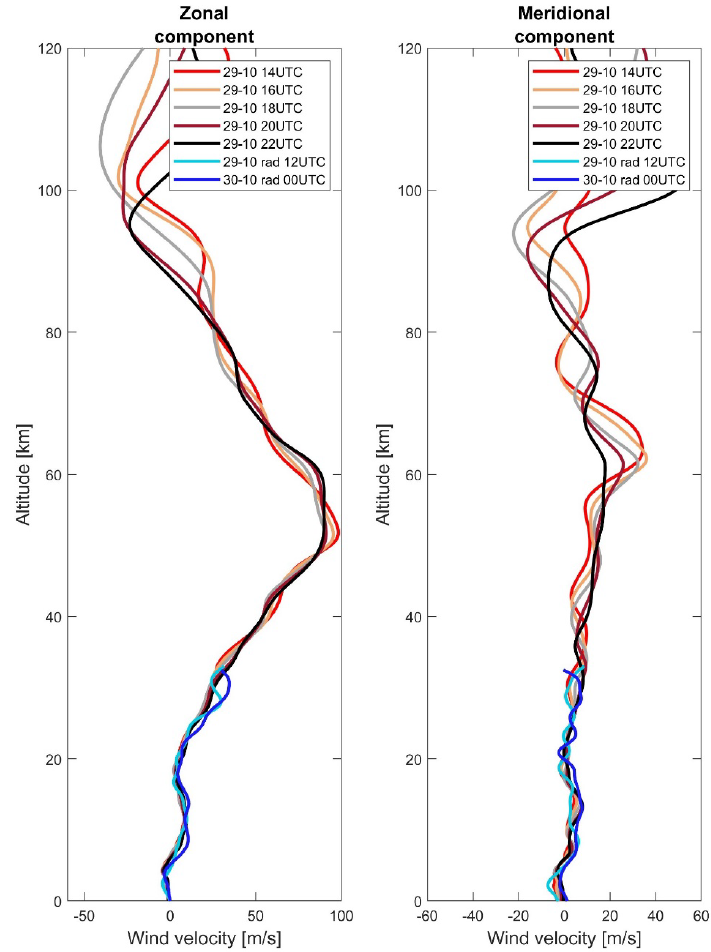
Figure 8. Example of G2S wind profiles plotted alongside radiosonde profiles for 29–30 October 2020. Radiosonde data extend to about 30 km altitude.